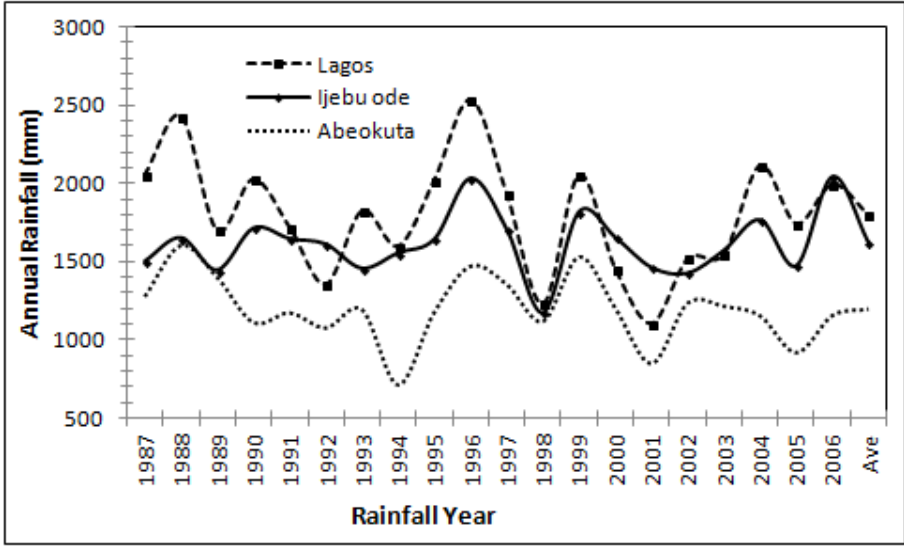
Figure 3. Annual rainfall of three areas of the Dahomey Basin. Table 4. Rating of net recharge for the Dahomey Basin.